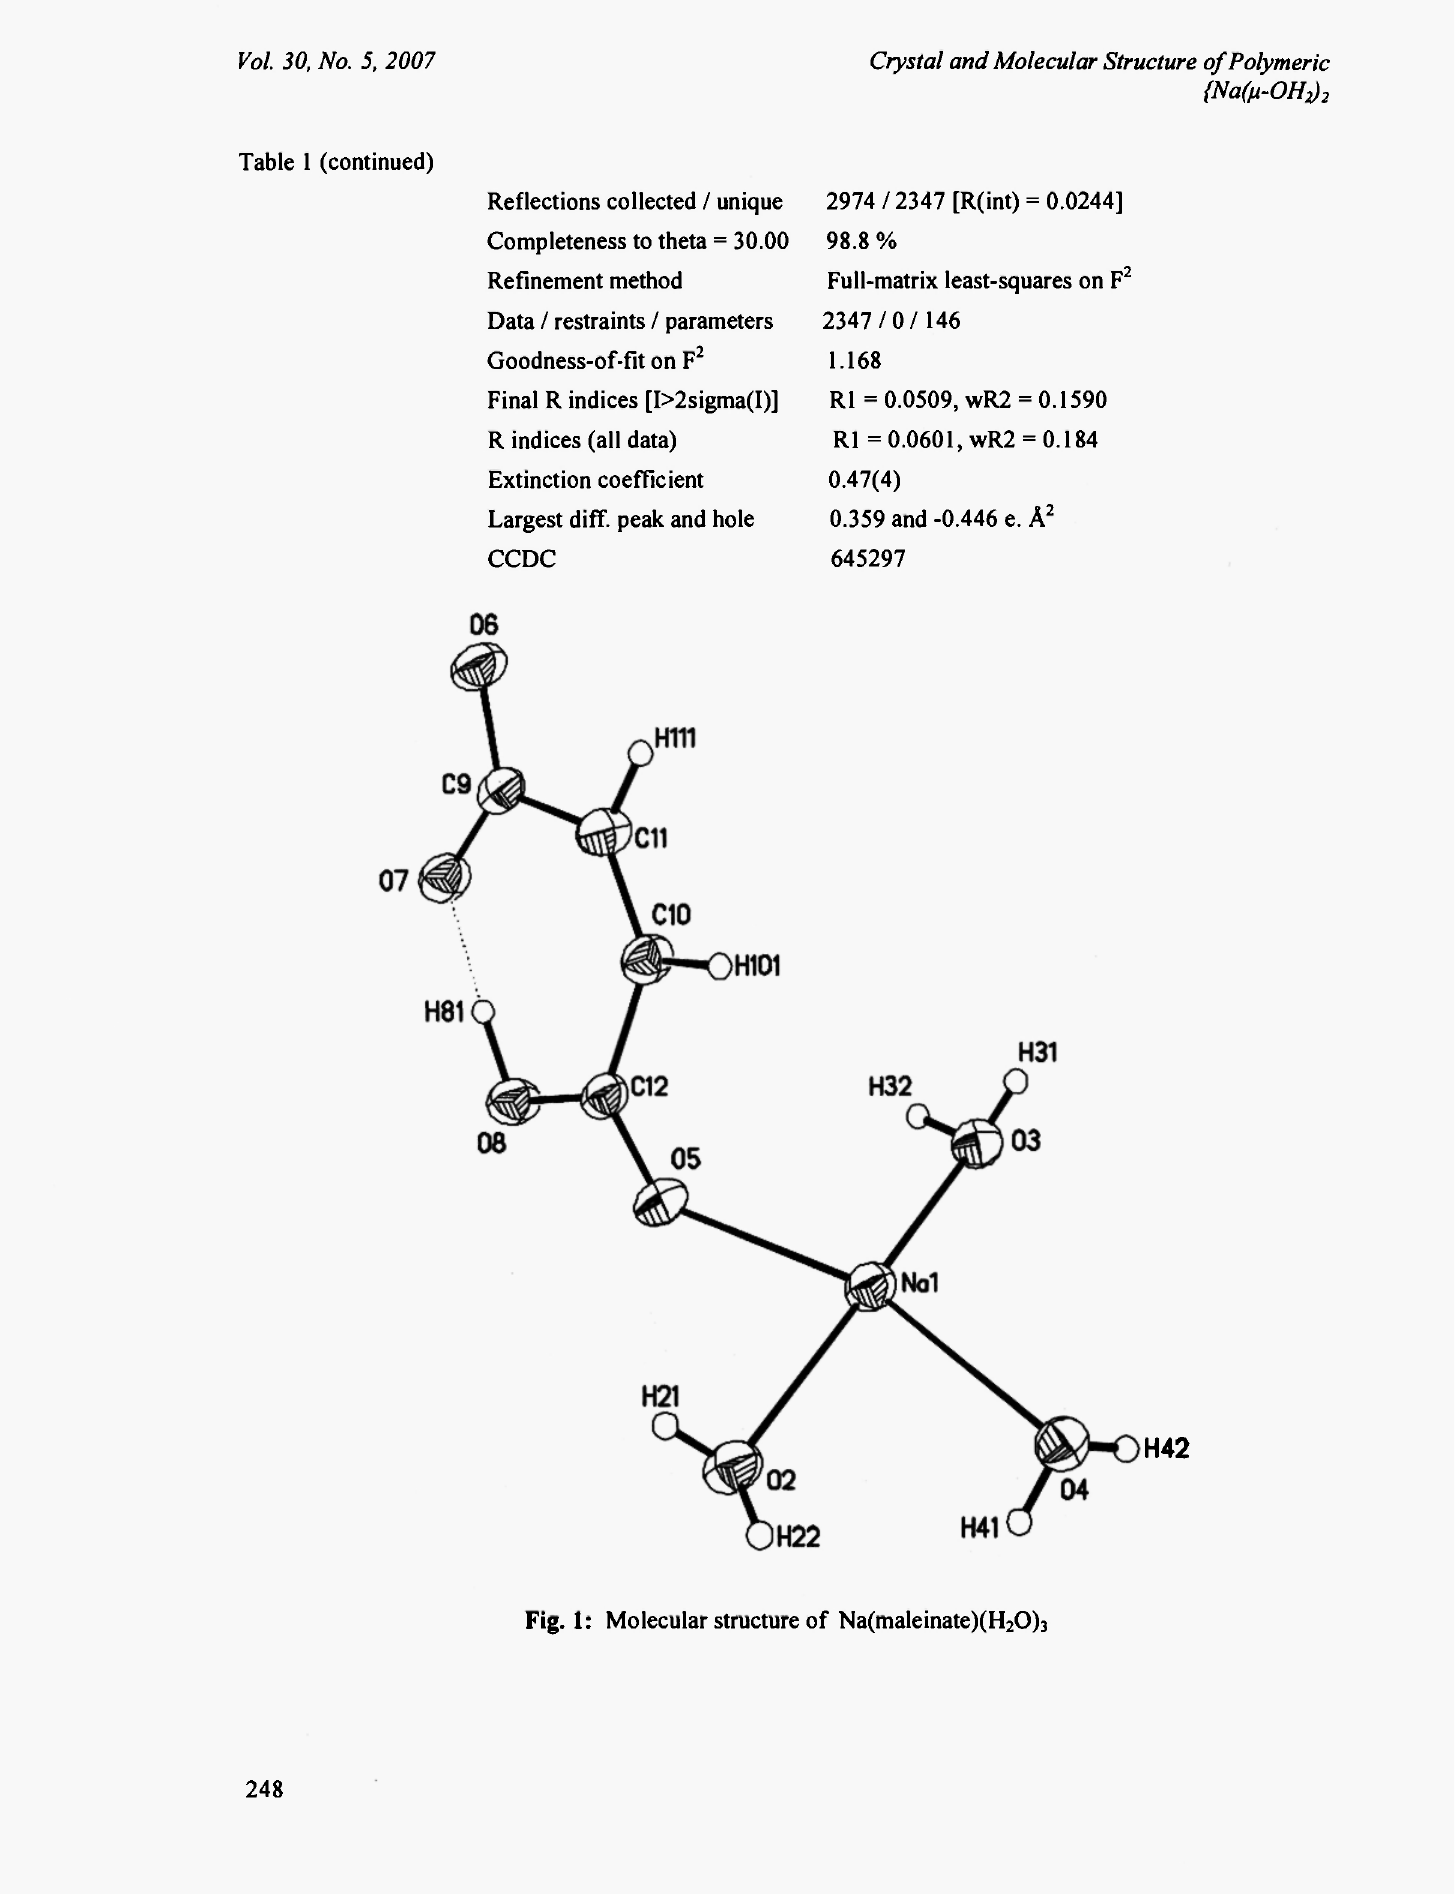
Fig. 1: Molecular structure of Na(maleinate )(H 2